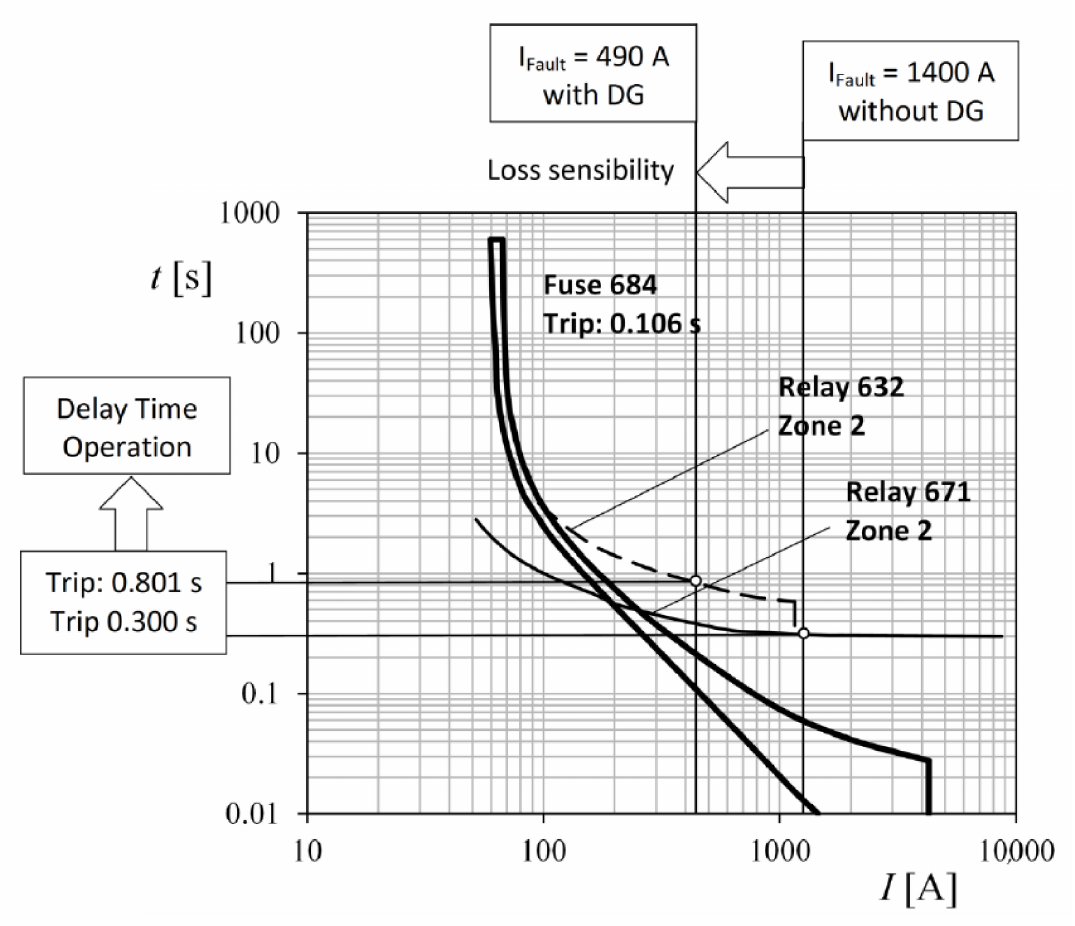
Figure 12. Protection Zone 3 current-time ( I-t ) performance in case of a three-phase short-circuit at point F2, with 25% DG power (1 MW) at bus 652 (see Figure 10).